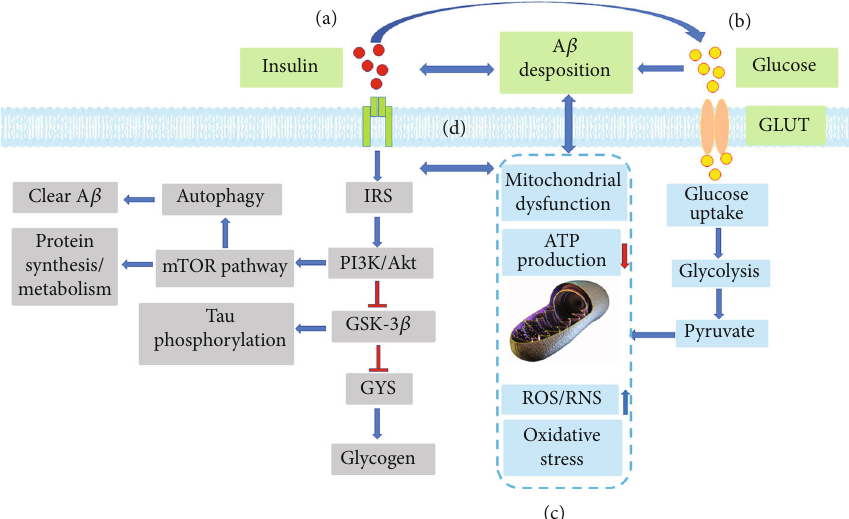
Figure 1: Overview of the insulin signaling pathway and relevant mechanisms implicated in AD. (a) Tyrosine phosphorylation of insulin receptor substrates (IRS) allows the association of IRSs with the regulatory subunit of phosphoinositide 3-kinase (PI3K). The PI3K/AKT signaling pathway deactivates glycogen synthase kinase 3 (GSK-3), leading to the activation of glycogen synthase (GYS) and thus glycogen synthesis. In addition, the PI3K/AKT signaling pathway can a ff ect protein synthesis/metabolism and clearance of A β by activating the mTOR pathway. (b) The insulin/insulin signaling pathway can promote glucose transportation by regulating GLUT, and high levels of glucose can lead to A β deposition. (c) Disordered glucose metabolism leads to ROS/RNS formation and decreased ATP production, which is the main manifestation of oxidative stress. Mitochondrial dysfunction can lead to impaired cellular energy production and reduction in insulin secretion and sensitivity. (d) Impaired insulin signaling pathway, A β deposition, and mitochondrial dysfunction promote each other to form a vicious